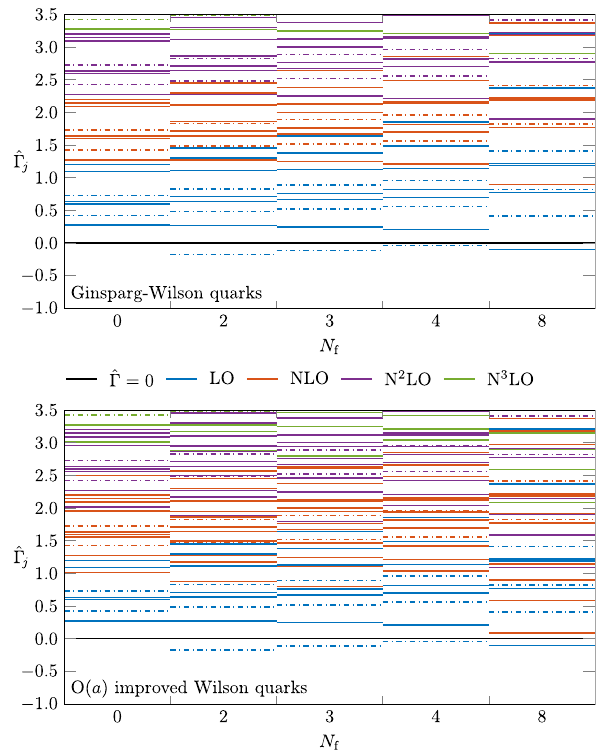
Fig. 3 Leading and subleading powers in the coupling ˆ (cid:2) j for the min- imal on-shell operator basis of GW and Wilson quarks, describing the leadingorderlatticeartifactsforspectralquantitiesat N f = 0 , 2 , 3 , 4 , 8. N f = 8 is added to highlight what happens when one gets closer to the conformal window. While the solid lines correspond to the massless operator basis (possibly containing massive mixing contributions), the dash-dottedlinesbelongtotheoperatorswithoverallmass-dependence. In case the tree-level coefficient vanishes, the first power plotted is regarded as NLO in the colour coding. Due to overlapping numerical values leading powers may be hidden by the “subleading” powers of other operators